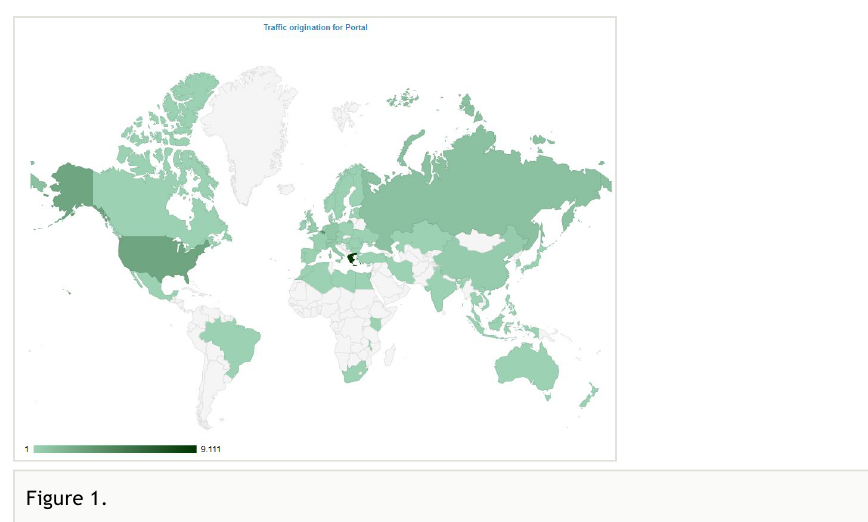
Geographic distribution of page requests received for the LifeWatchGreece web services during the academic year